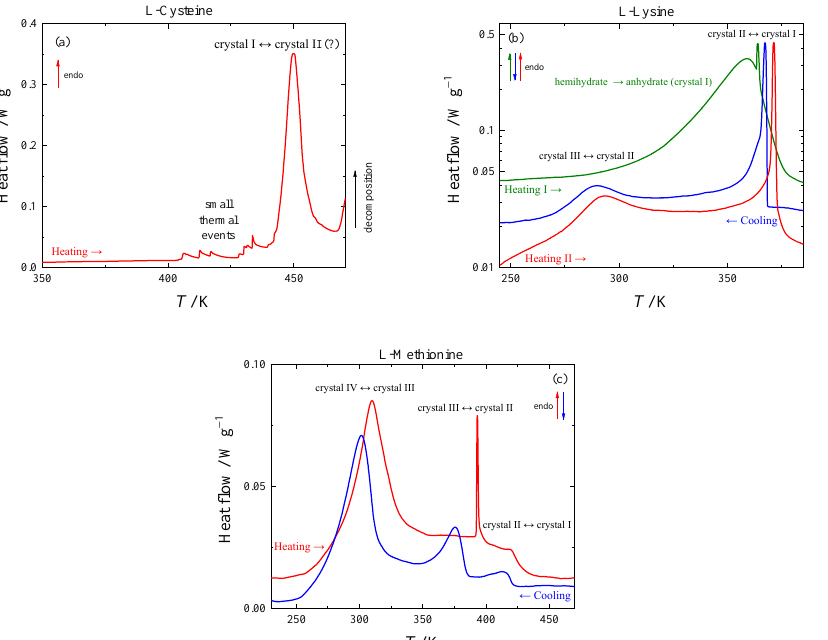
Figure 2. Thermograms obtained using DSC TA Q1000 for ( a ): L-cysteine, ( b ) L-lysine (logarithmic scale), ( c ): L-methionine. Line colors distinguish individual thermal cycles. Three structures of L-methionine (II, III, and IV), all with disordered side chains, were recently solved [29]. On the other hand, previous crystal structure reports at lower [44,45]